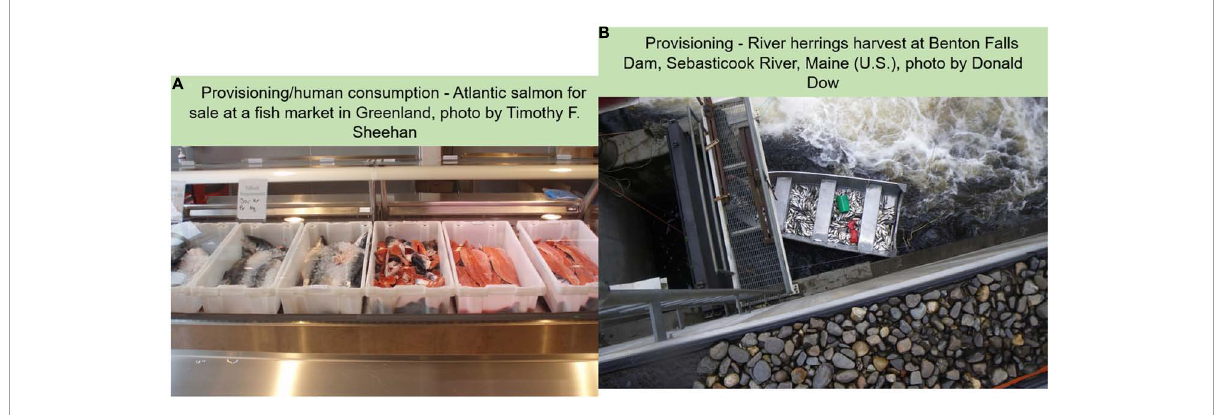
FIGURE3 Visual examples of provisioning services.